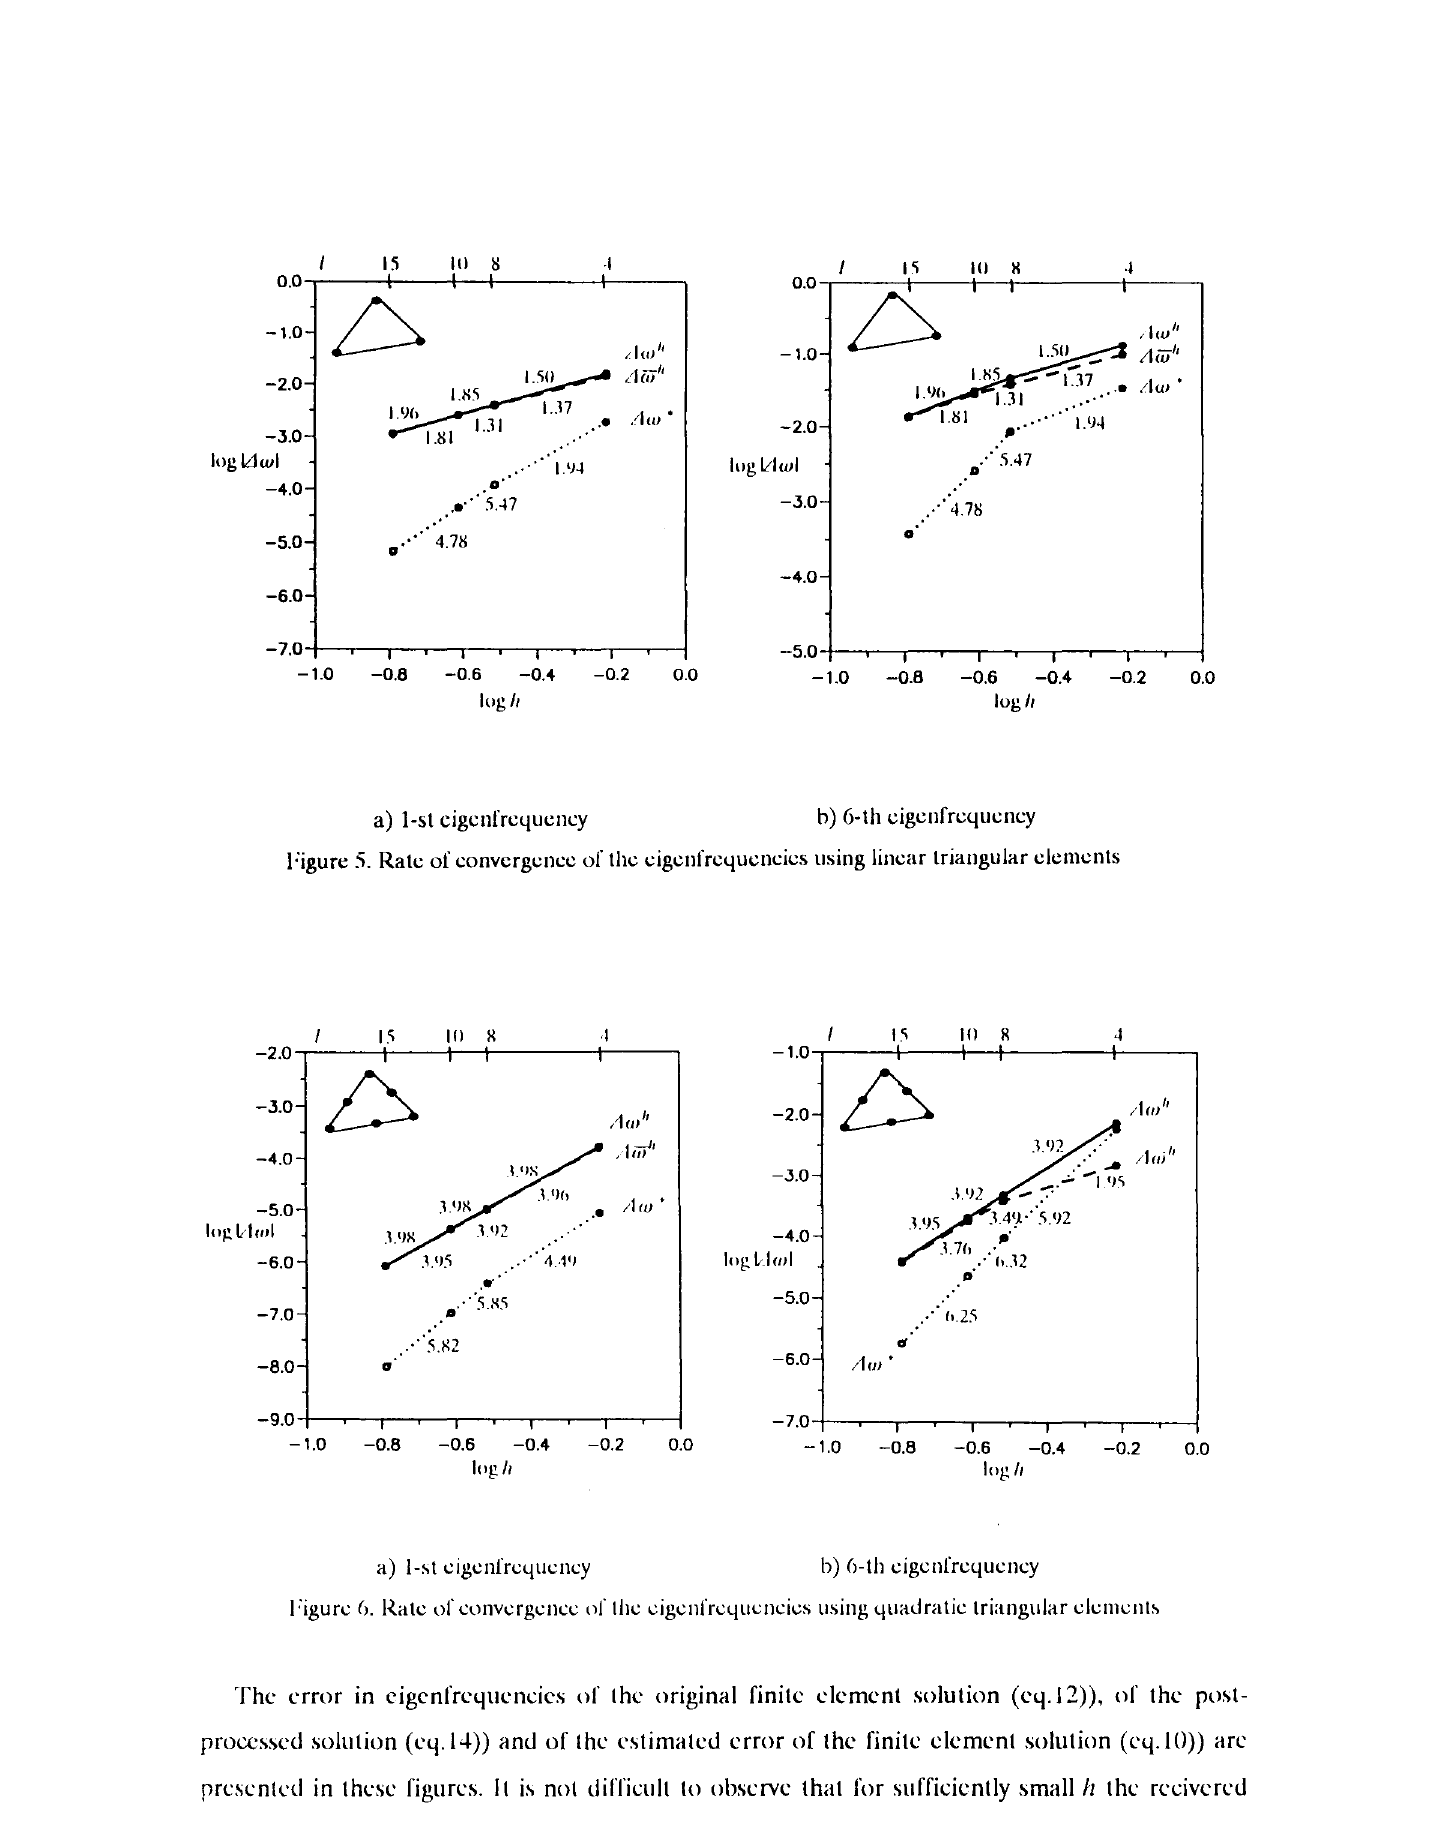
The error in cigcnfrl·yuencics of the original finite clement solution ( cy.l2)), of the po~t­ proccs~ed solution (c4.14)) and of the l'stimatcd error of the finite clement solution (c4.l0))